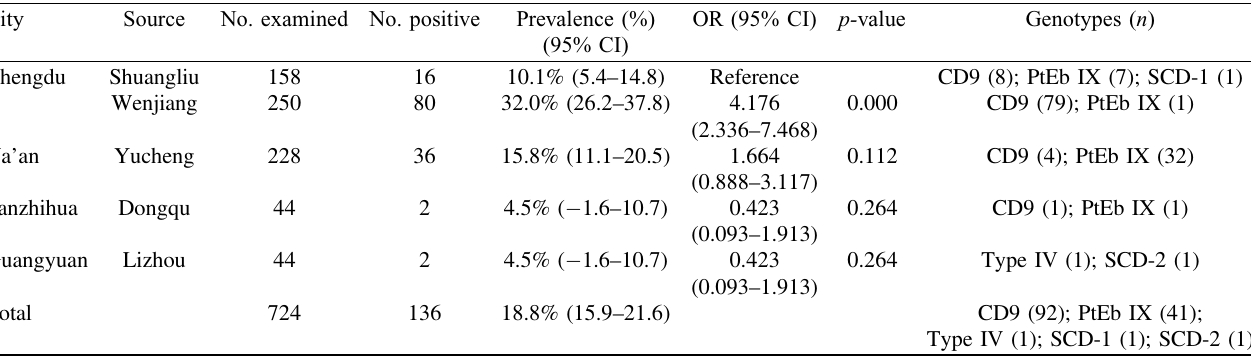
Table 1. Prevalence and genotypes of E. bieneusi in sheltered dogs from different cities and sources in Sichuan province, southwestern China. City Source No. examined No. positive